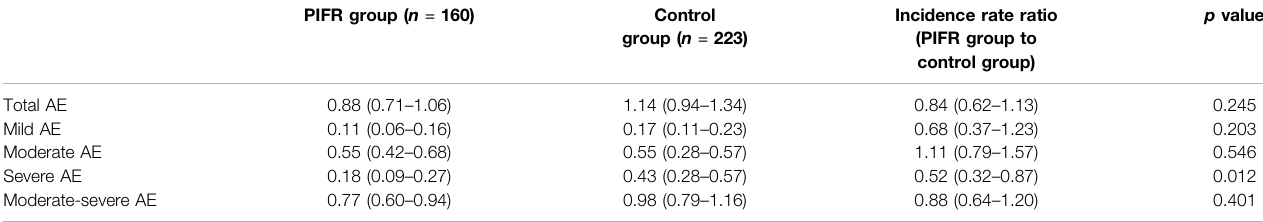
TABLE 2 | One year incidence rates and incidence rate ratios of acute exacerbation in respect of severity among the study subjects.